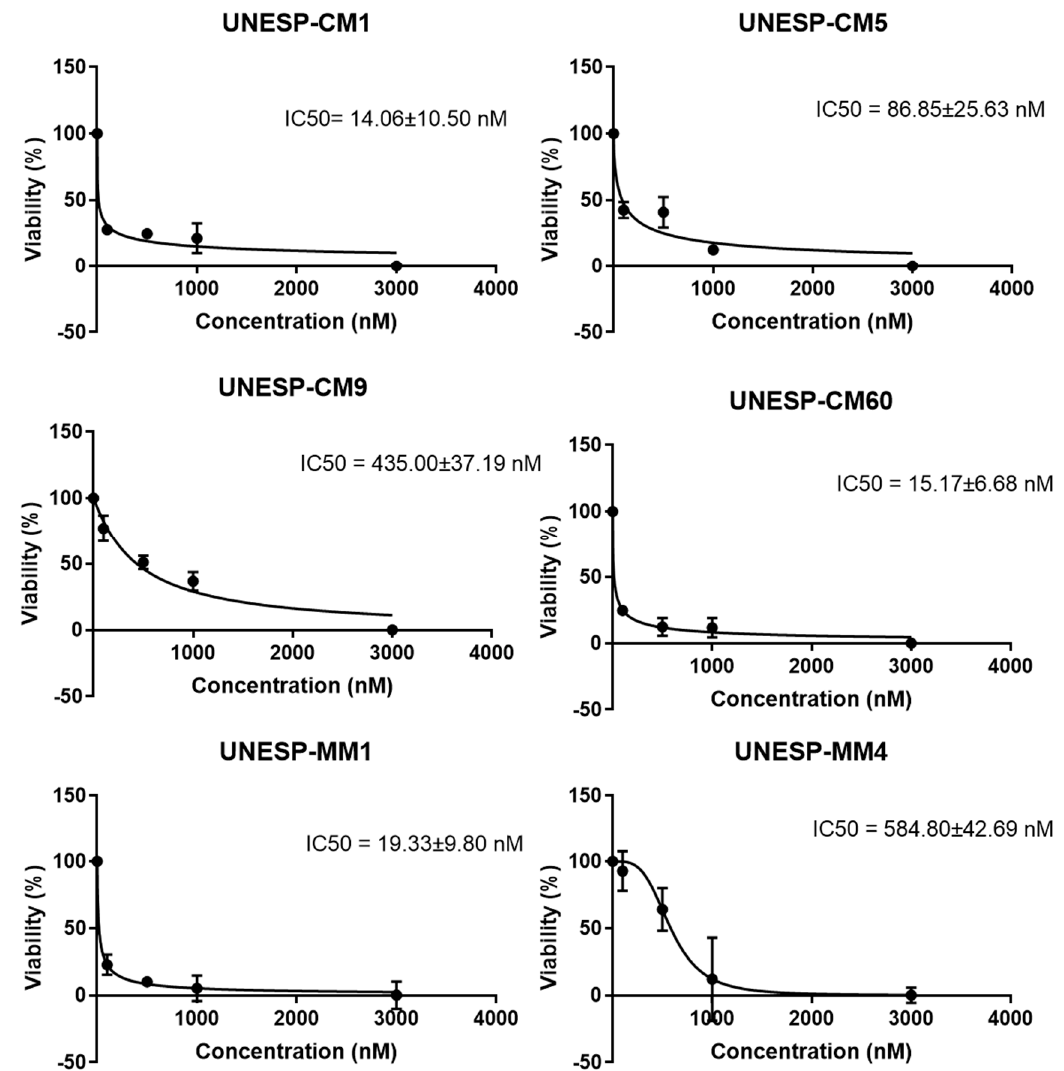
Figure 3. Percentage of viable cells in an MTT assay of primary cultures of canine breast carcinoma (UNESP-CM1, UNESP- CM5, UNESP-CM9 UNESP-CM60) and metastases (UNESP-MM1 and UNESP-MM4) treated with lapatinib at 100, 500, 1000 or 3000 nM for 24 h.